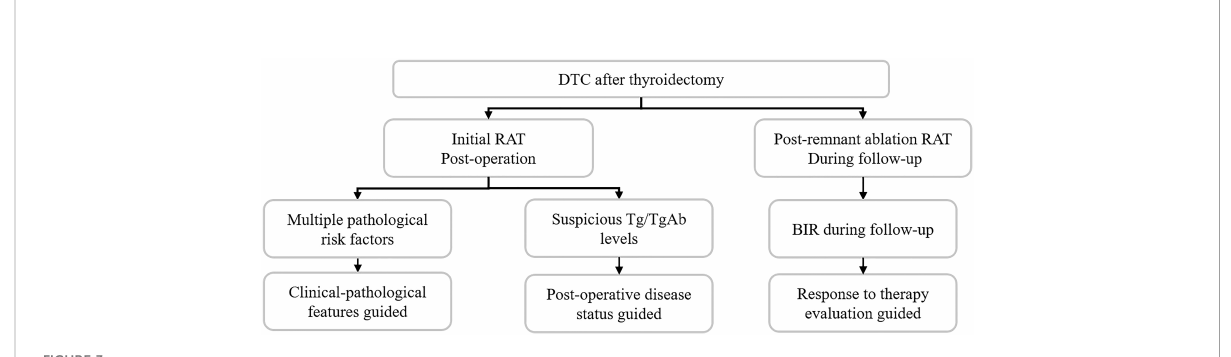
FIGURE 3 Current factors guided RAT decision-making.